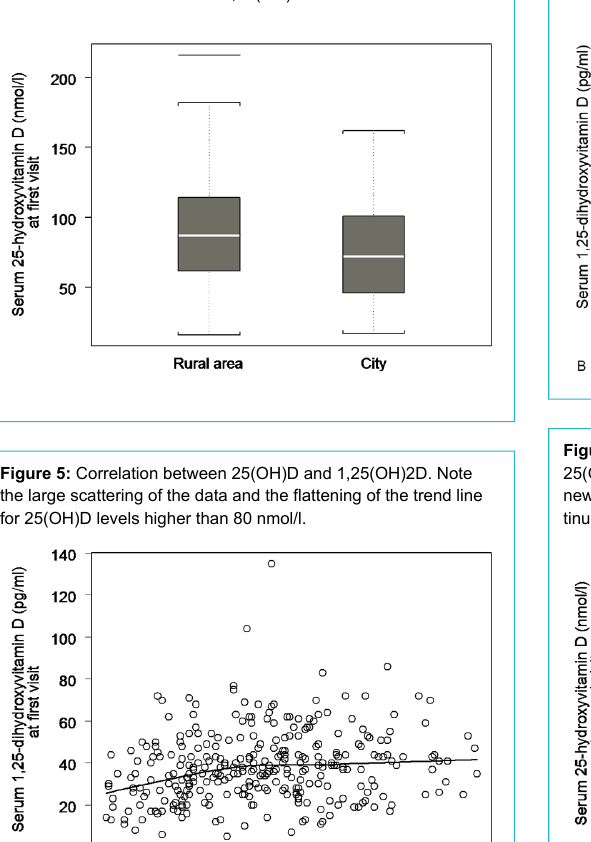
Figure 4: Living in a rural area was associated with a higher medi- an 25(OH)D level as compared with living in an urban area; the same trend was observed for 1,25(OH)2D.